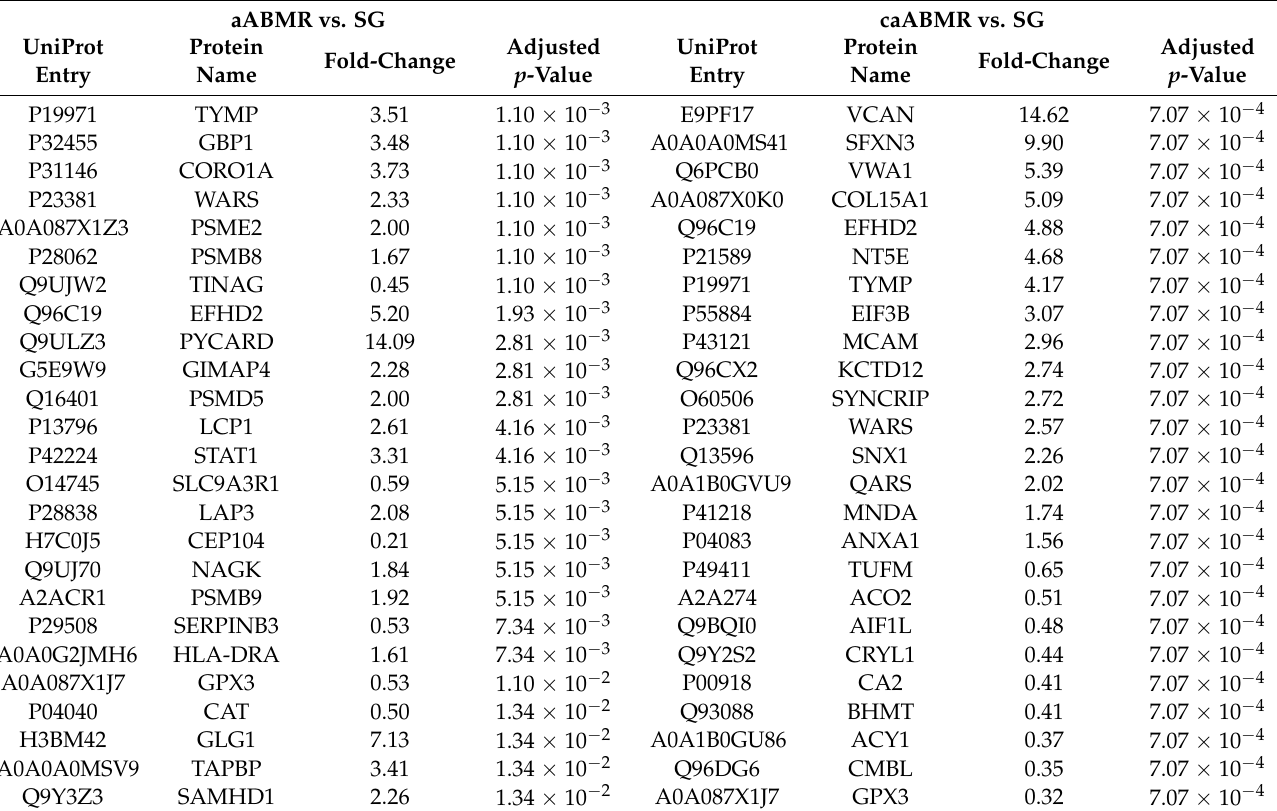
Table 2. Top-25 proteins differentially represented between active ABMR, chronic active ABMR and stable